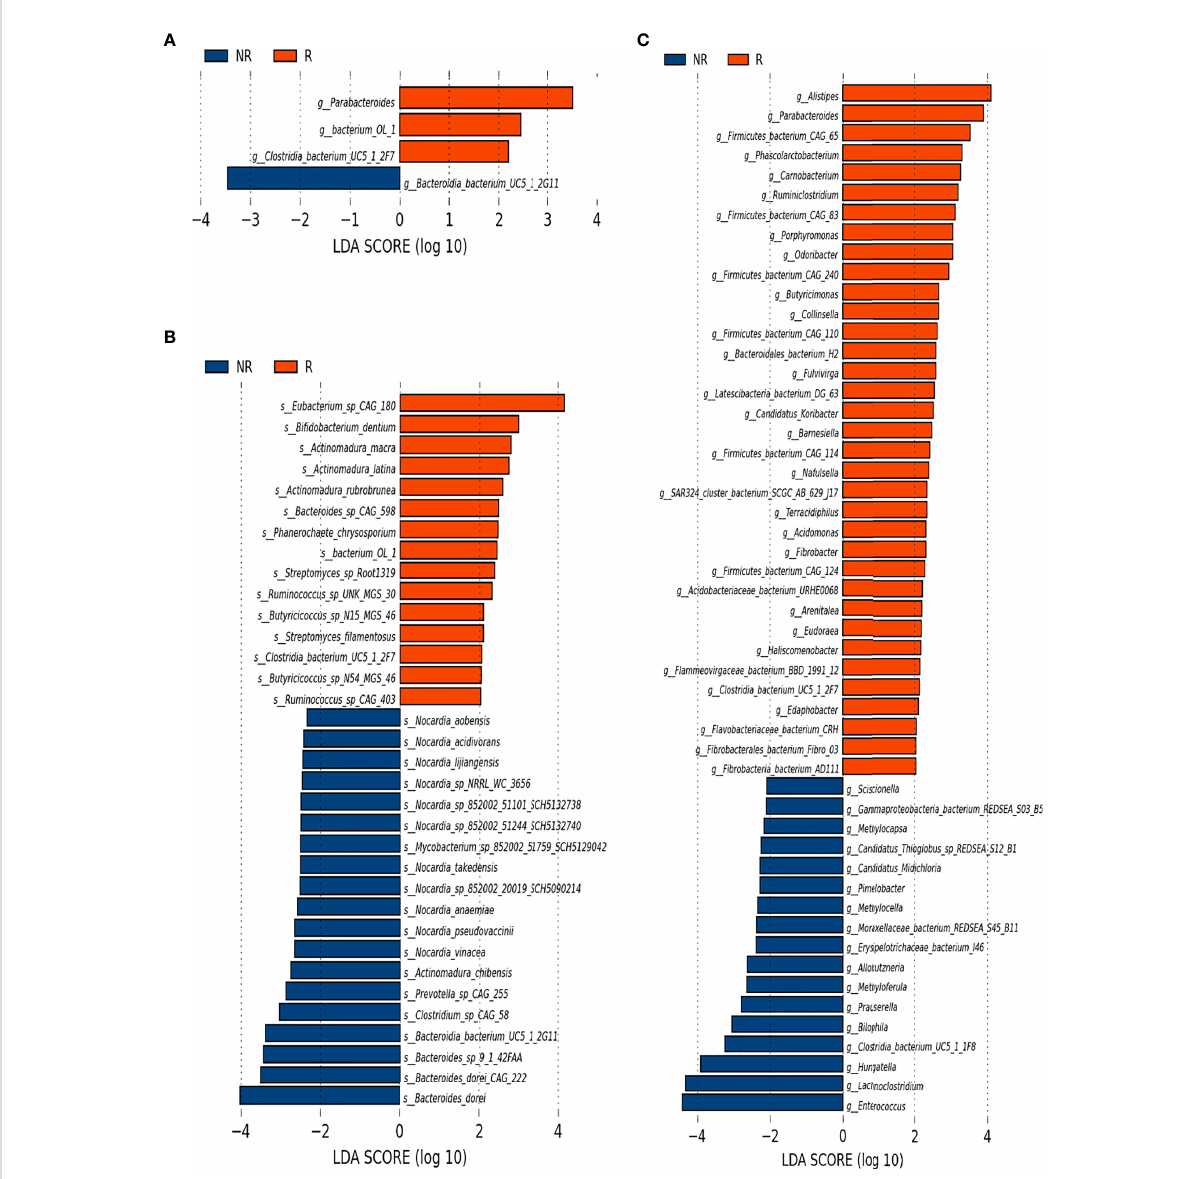
FIGURE 4 Microbiota composition differences between the R group (n = 16) and the NR group (n = 8). (A) The relative abundance of R-enriched and NR- enriched genera and (B) species at baseline. (C) The relative abundance of differentially abundant genera at 6 weeks, as identi fi ed by LEfSe analysis (Kruskal – Wallis sum rank test, P <